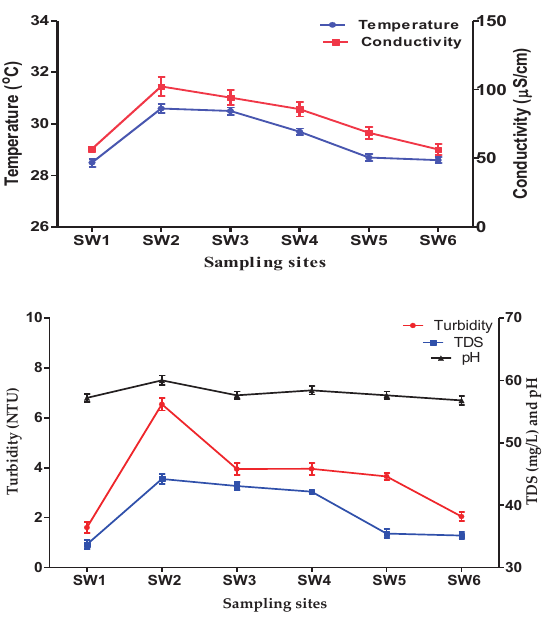
Figure 2: Temperature and Conductivity, pH, turbidity an TDS values for leachates from Mpape dumpsite and different surface water samples collected along Ndawuse